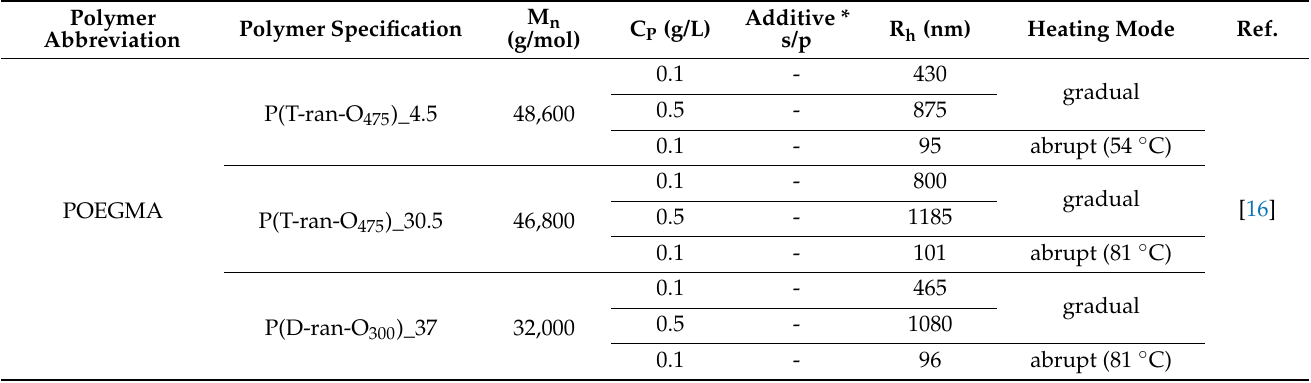
Table 1. Polymer characteristics, experimental conditions and properties of mesoglobules prepared in the Laboratory of Nano- and Microstructural Materials of CMPW